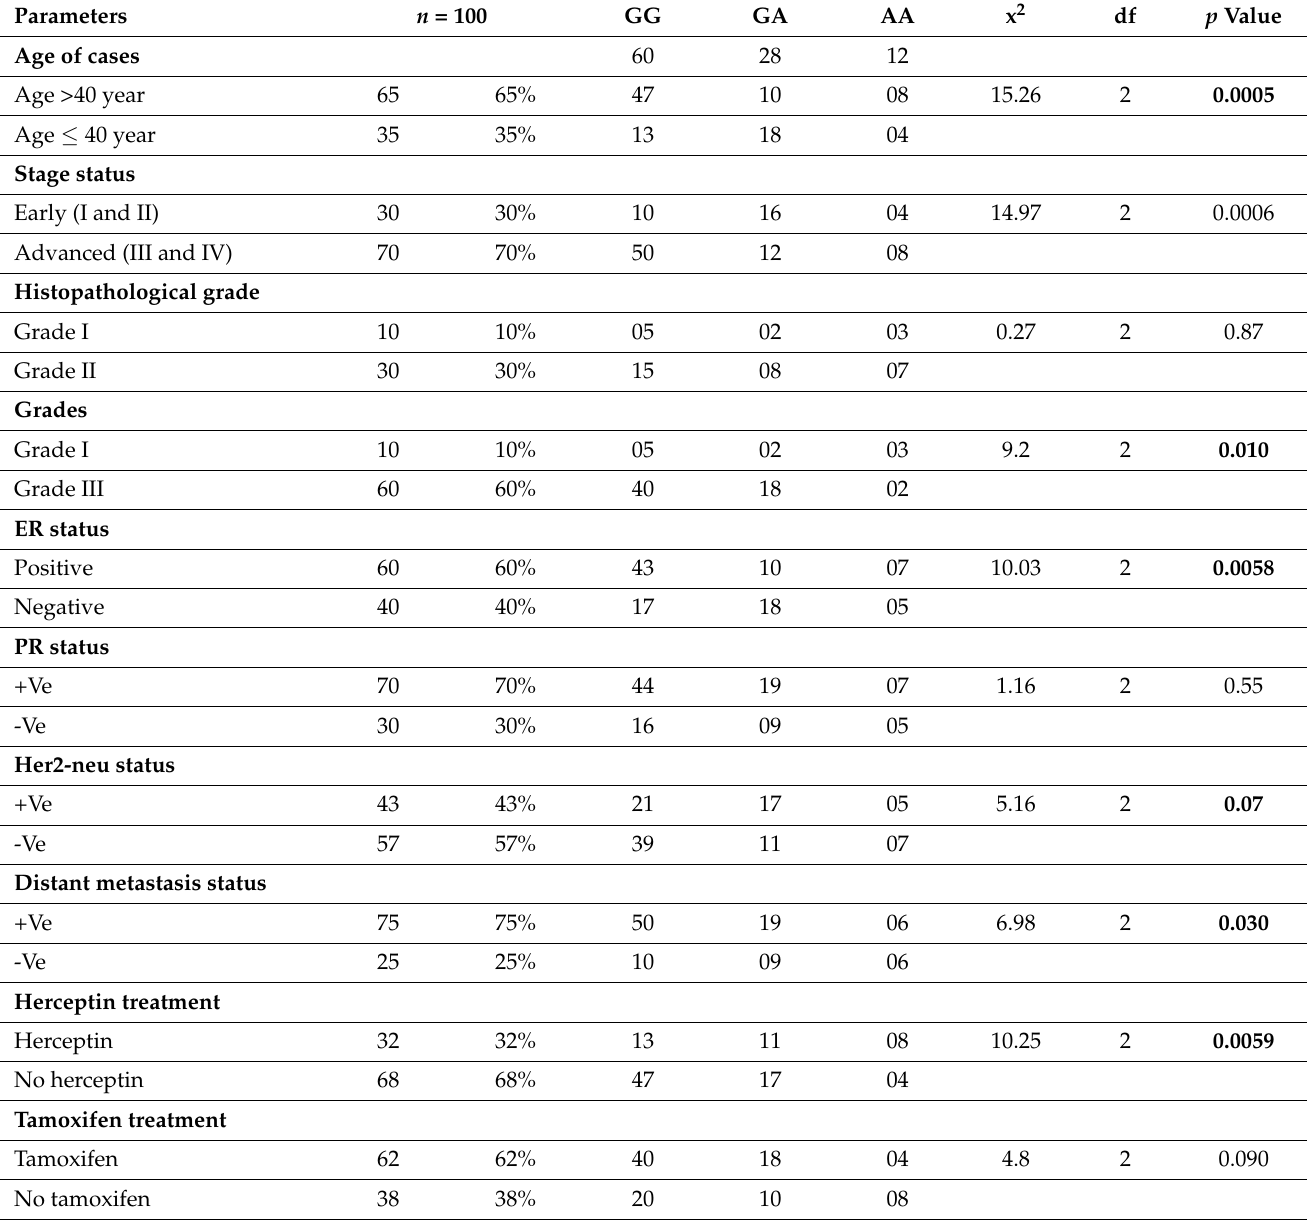
Table 12. Association of clinicopathological characteristics of breast cancer patients and the miRNAs 27a rs895819 A > G genotype. p values in bold are